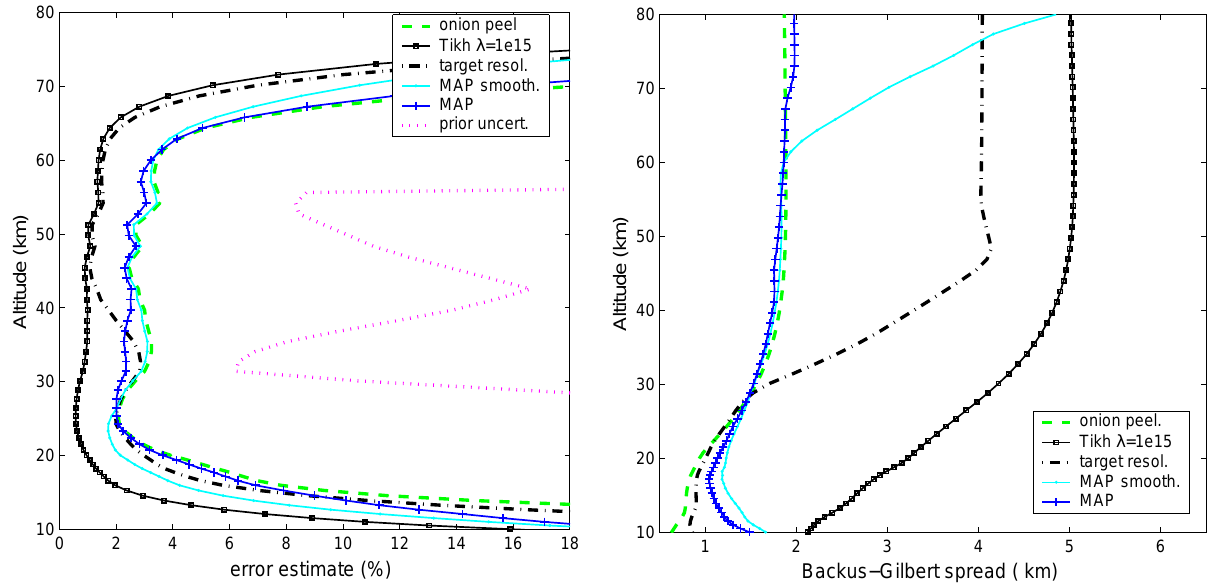
Fig. 6. Error estimation (left) and resolution (right) achieved with different inversion methods. Simulations are carried out for star of magnitude m = 2 and effective temperature T =